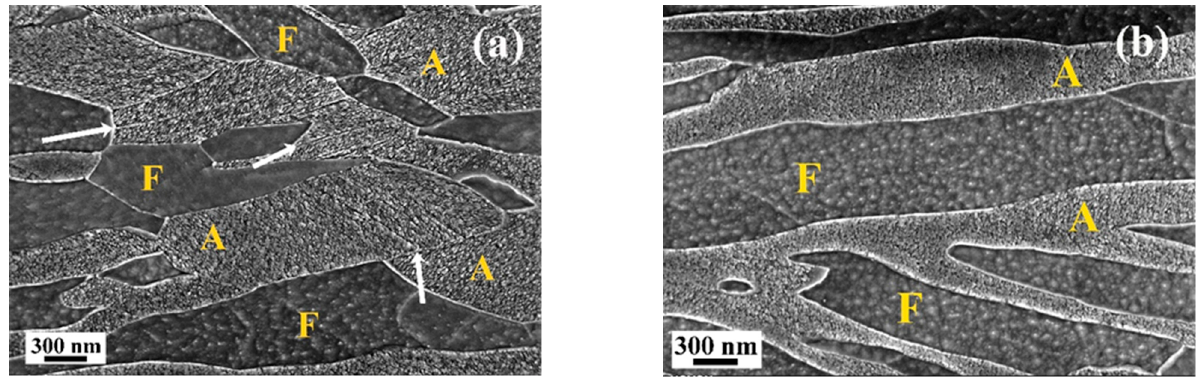
Figure 13. SEM micrograph showing no indication of DIB, and only some austenite grains containing twin traces after the specimen was tested to fracture at 300 °C. F: ferrite, A: austenite.